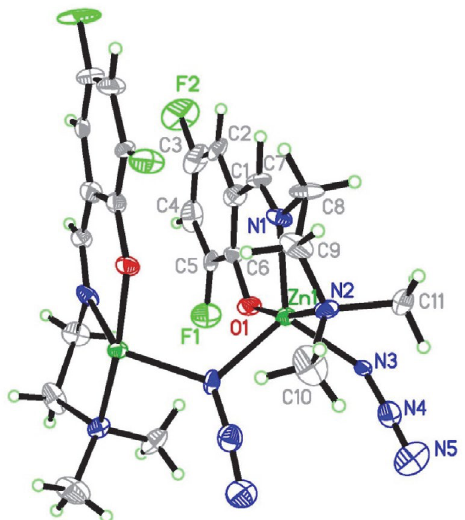
Figure 3. Molecular structure of complex 2 , with 30% thermal probability. Unlabeled atoms are at the symmetry position x , ½ – y , ½ + z